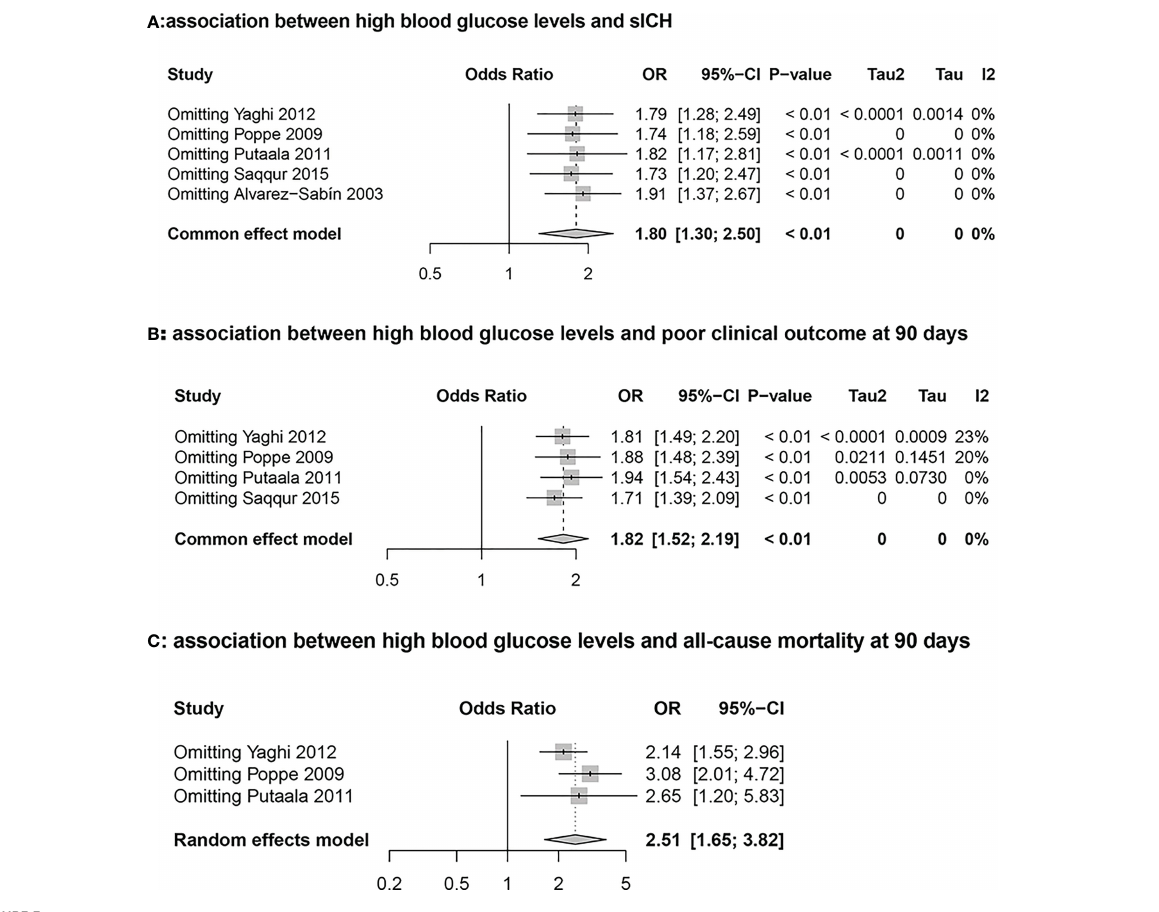
FIGURE 3 Sensitivity analysis graph for the high glucose and non-high glucose groups. (A) : Association between hyperglycemia and symptomatic intracranial hemorrhage (sICH) (B) : Association between hyperglycemia and poor clinical outcome at 90 days (C) : Association between hyperglycemia and all- cause mortality at 90